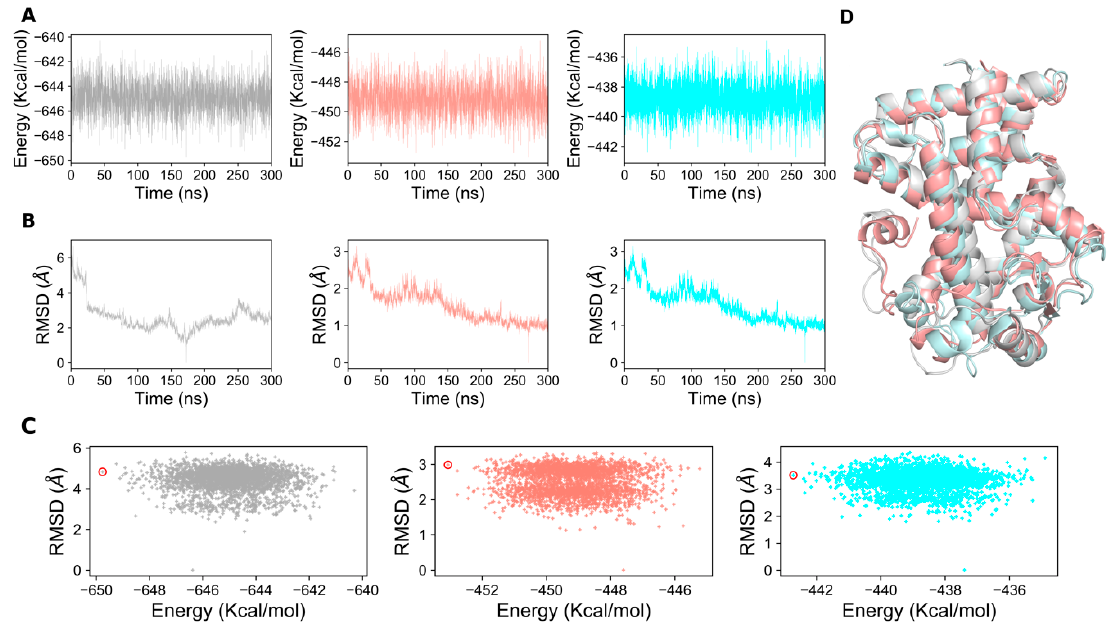
Figure 6. Structure and dynamics of PPAR- α complexes. ( A ) Time-dependent total conformational energy of apo, agonist-, and antagonist-bound forms; ( B ) RMSD in reference to the minimum energy structure from the MD trajectories of the apo, agonist-, and antagonist-bound forms; ( C ) RMSD plot with respect to the total conformational energies of apo, agonist- and antagonist-bound complexes. For clarity purpose, minimal energy structures of PPAR- α complexes are illustrated in red circle. ( D ) The minimum energy structures of apo, agonist, and antagonist-bound forms are overlaid to show the significant structural difference between the three forms. Gray represents apo-form, salmon represents agonist-bound form, and cyan represents antagonist-bound form of PPAR- α .